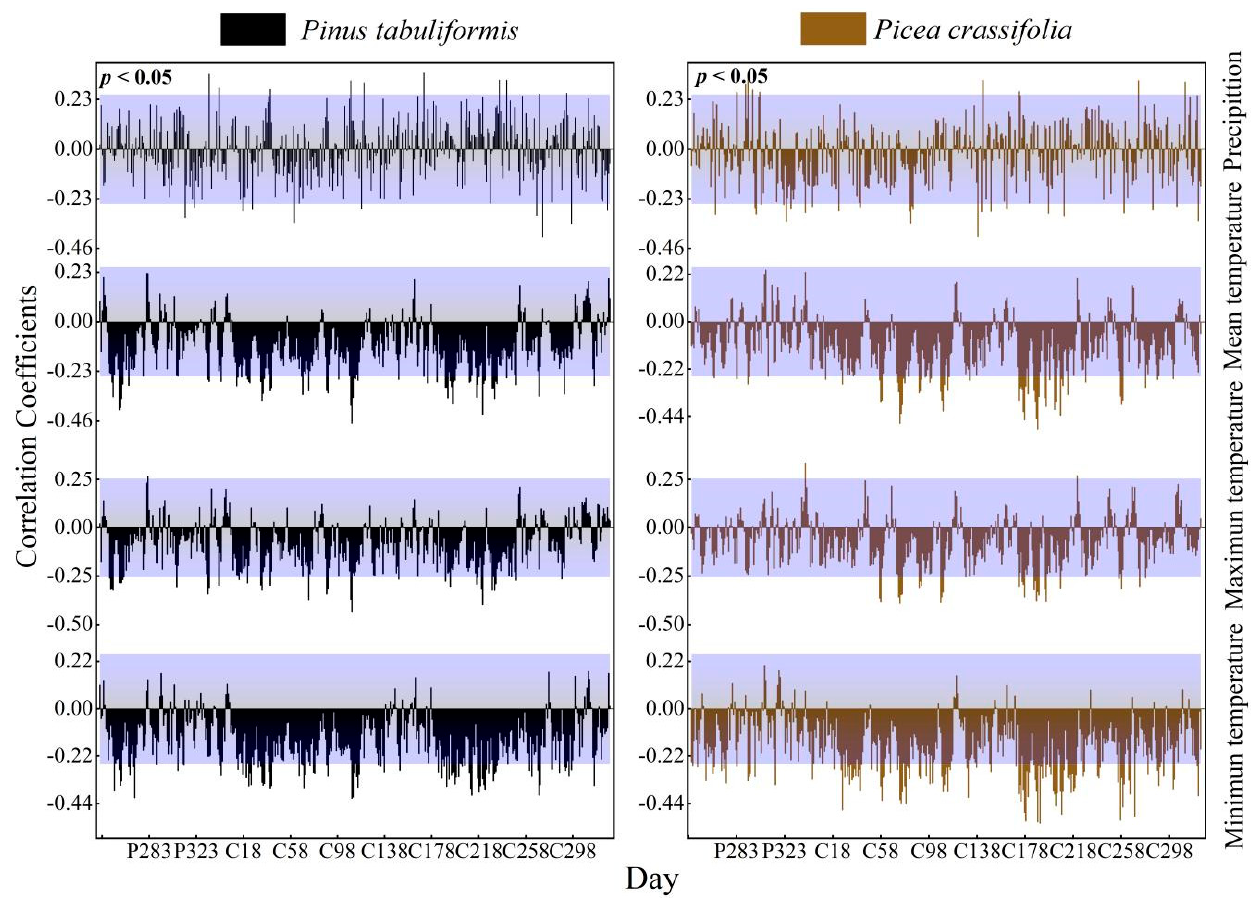
Figure 7. Response of the radial growth of trees to daily values of climatic factors (Beyond the top of the purple shade, p values are positively correlated ( p < 0.05), lower than the part in purple shadow indicates that p values are negatively correlated ( p < 0.05). Table 3. The maximum correlation coefficient between the tree ring index and climate factors at different timescales.